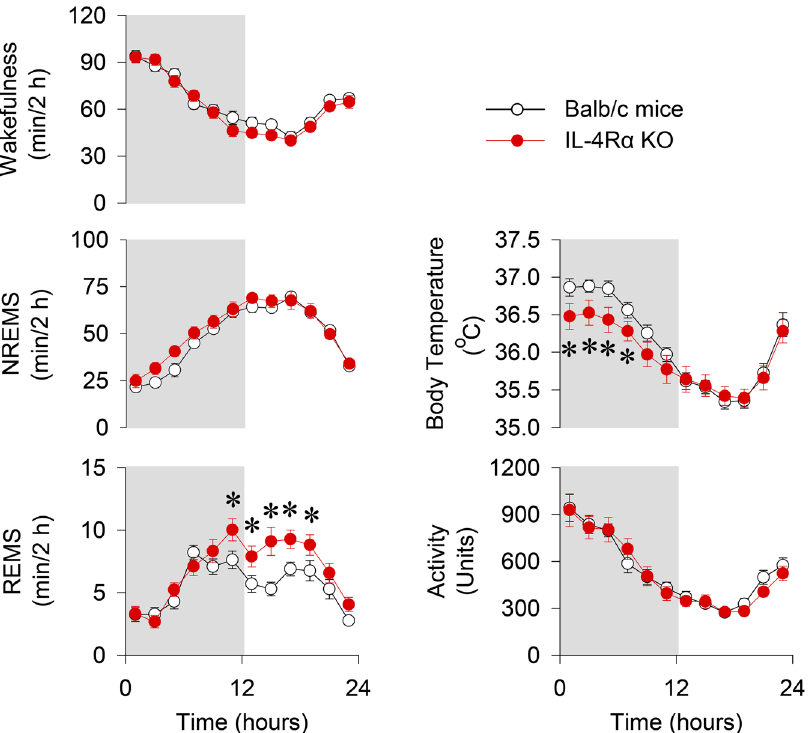
Figure 1. Spontaneous diurnal rhythms of wakefulness, non-rapid-eye movement sleep (NREMS), rapid-eye movement sleep (REMS), body temperature and locomotor activity in WT (white circles) and IL-4R α KO (red circles) mice at 30 °C ambient temperature. Data are calculated in 2-h time blocks; grey shaded areas represent the dark period. Error bars represent SEM. Asterisks indicate significant difference between WT and KO mice, Tukey’s HSD test, P <